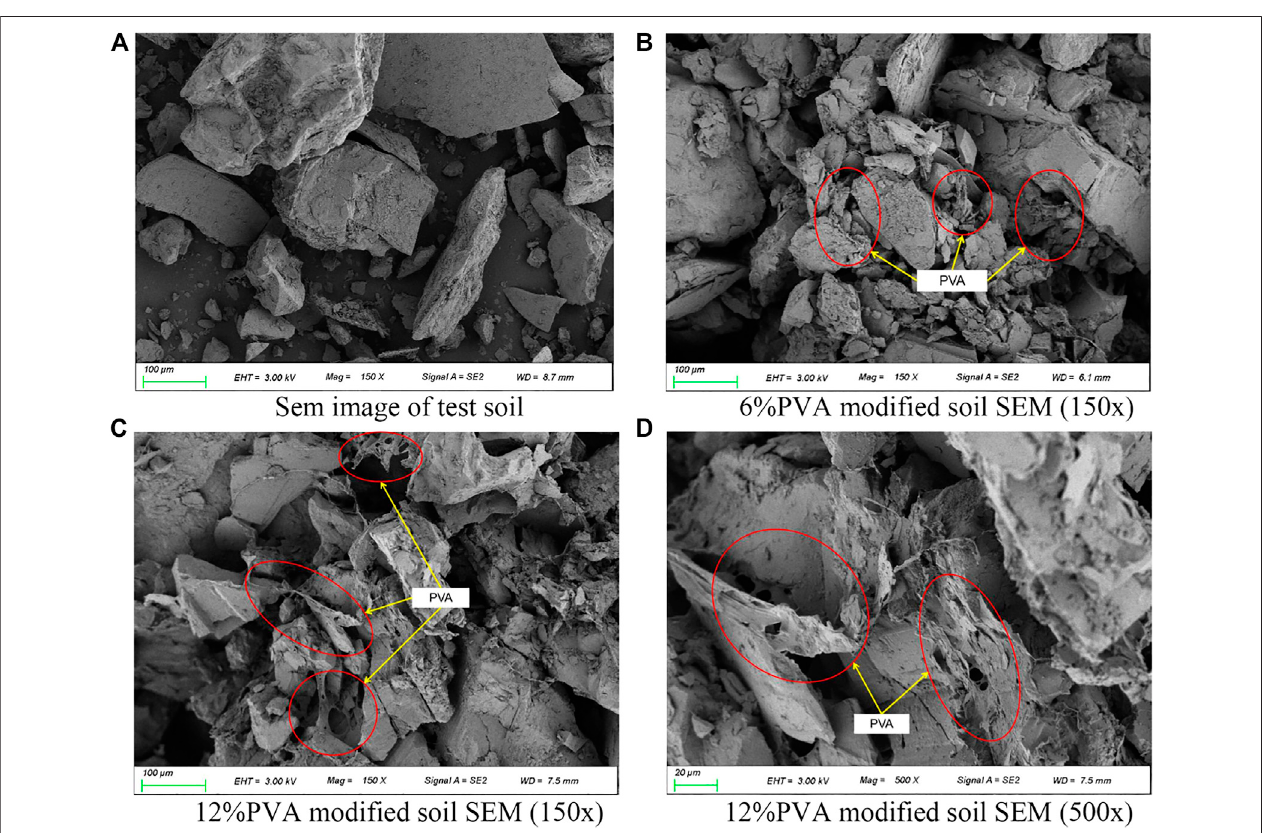
FIGURE 8 | Scanning electron microscopy image: (A) test soil. (B) 6% PVA modi fi ed soil (150X). (C) 12% PVA modi fi ed soil (150X). (D) 12% PVA modi fi ed soil (500X).